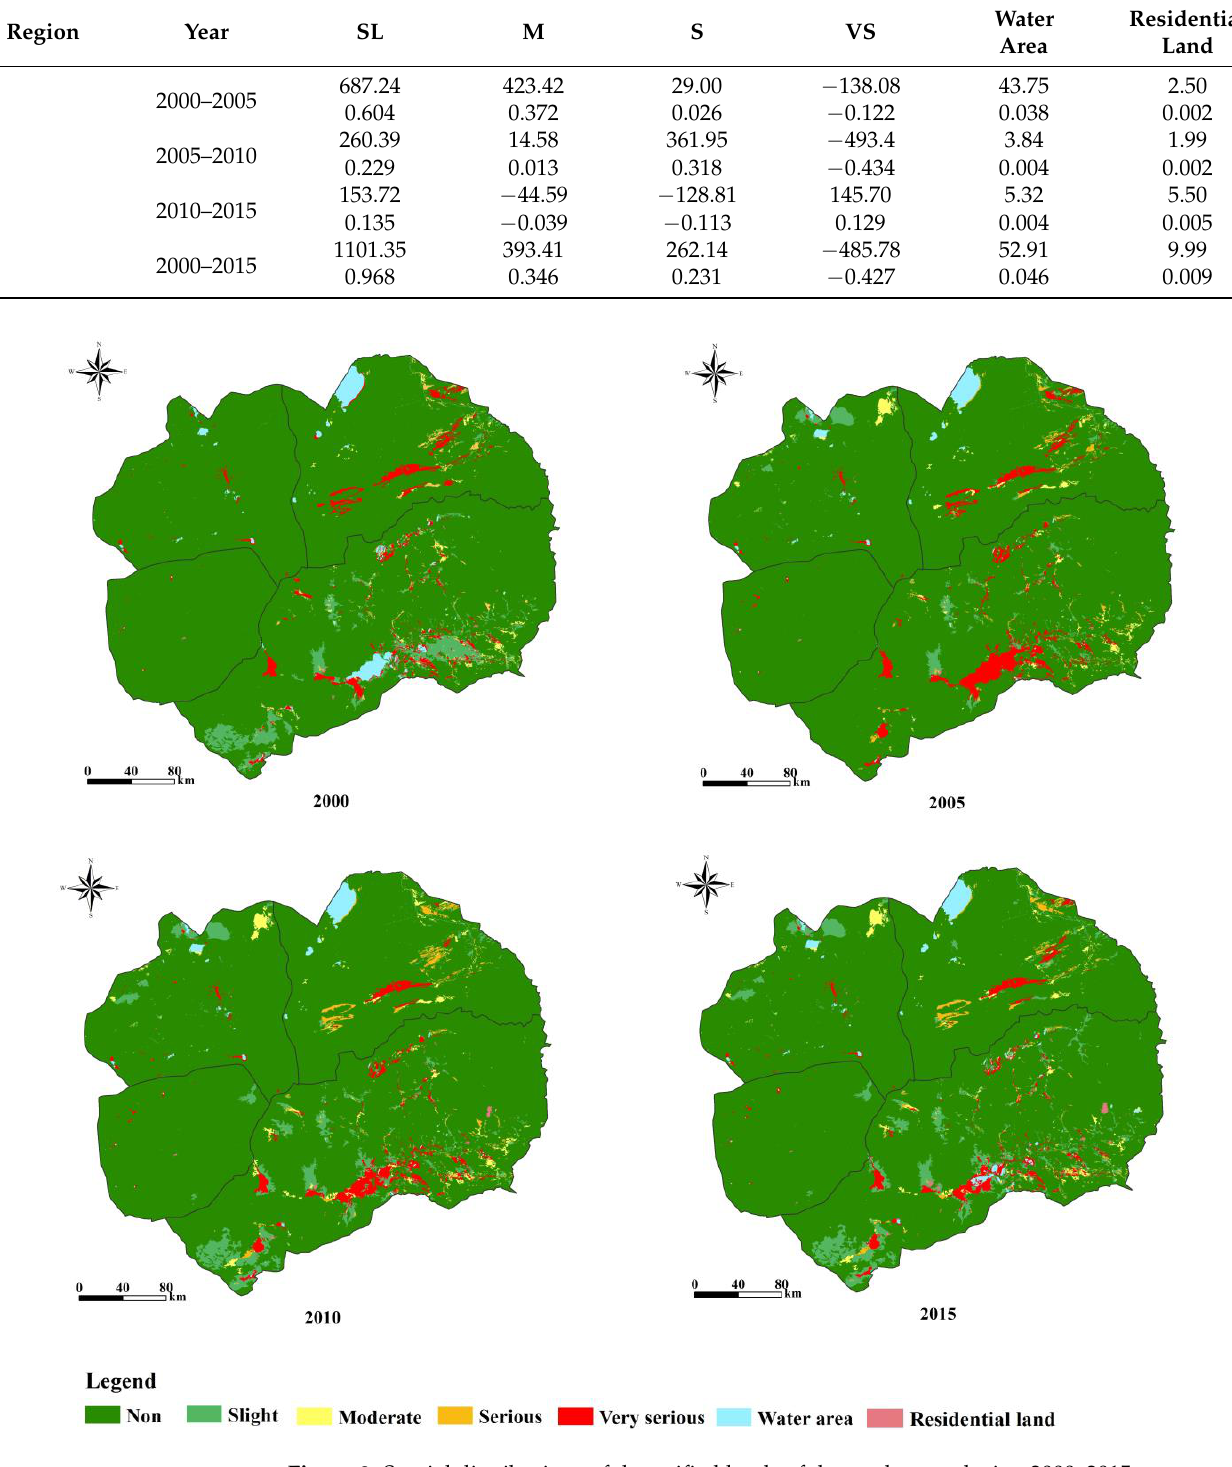
Figure 3. Spatial distributions of desertified lands of the study area during 2000–2015. Desertification in the three counties of Mongolia has undergone the process of development, mild development, and mild development. However, the areas of desertified land were considerably smaller than those of the East Ujimqin Banner. In 2005 and 2010, the three counties of Mongolia were dominated by VS, with areas 1197.02 km 2 and 1058.94 km 2 , occupying 1.053% and 0.931% of the study area, respectively. vs. was widely distributed in the southern and eastern parts of Chalchyn Gol County and around the water areas of the three counties (Figure 3). M and S were mainly distributed around the vs. in Chalchyn Gol County, growing to 423.42 km 2 and 29 km 2 respectively during 2000–2005. In addition to the M part that changed from VS, a large part of M occurred at the northern edge of Matad County (Figure 3a,b). S increased by 361.95 km 2 between 2005 and 2010, mainly due to the transformation of vs. in the northeastern and southwestern parts of Chalchyn Gol County (Figure 3b,c). In 2000, the SL area in the three counties was 124.75 km 2 , but it increased by 0.604% in 2005. The newly added SL was found mainly at the northern edge of Matad County (Figure 3b). In 2010 and 2015, a new SL appeared in northwest Matad County and northeast Erdenetsagaan County (Figure 3c,d).